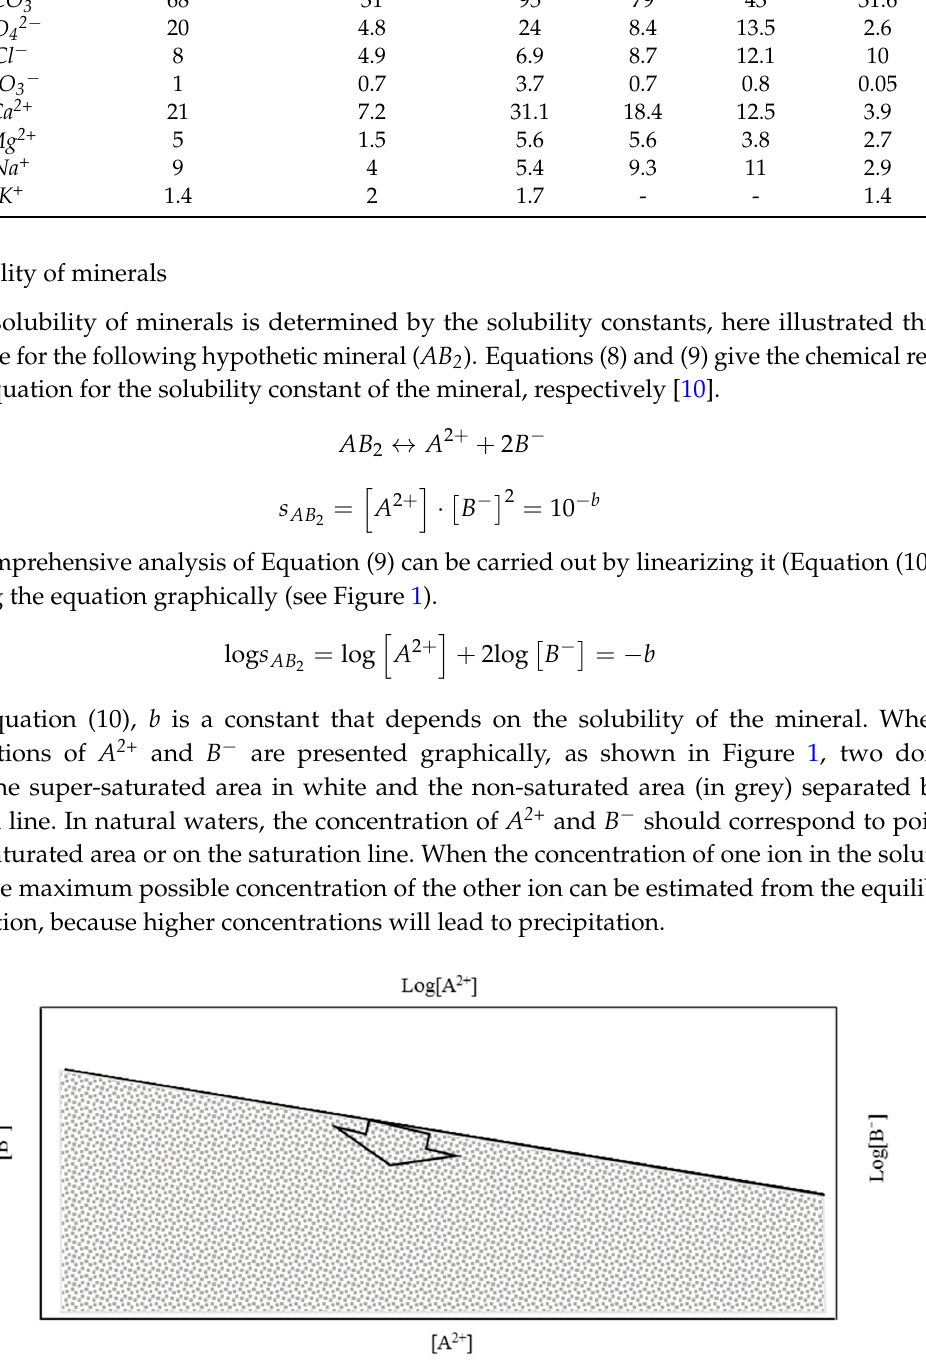
Table 1. Average concentrations of MI in rivers per continent (ppm) [12,19]. Continent North America South America Europe